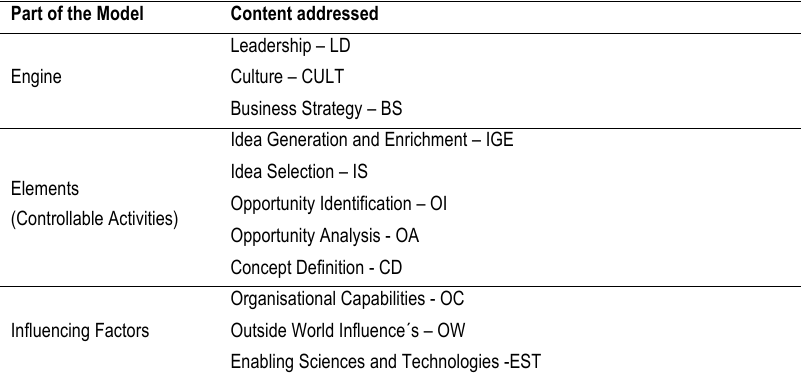
Table 4. NCD Model´s